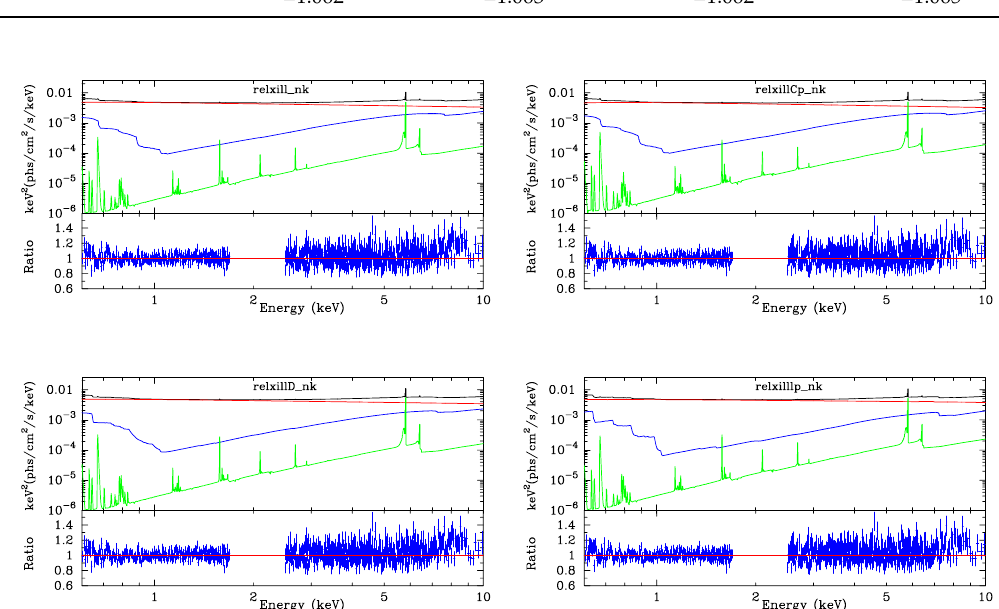
Figure A5. Spectra of the best fit models with the corresponding components ( upper panels ) and data to best-fit model ratios ( lower panels ) for 1H0419–577 when the reflection component is modeled by RELXILL _ NK ( top left panel ), RELXILL C P _ NK ( top right panel ), RELXILL D_ NK ( bottom left panel ), and RELXILLLP _ NK ( bottom right panel ). The total spectra are in black, power law components from the coronas are in red, the relativistic reflection components from the disk are in blue, and the non-relativistic reflection components from cold material are in